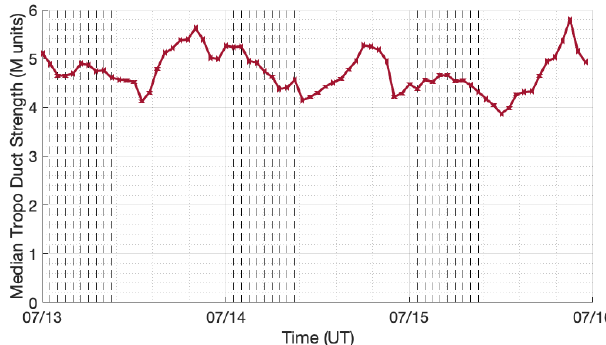
Figure 5. Median nonzero tropospheric duct strength between 25– 50 ◦ N and 85–50 ◦ E between 13–15 July 2021. Nighttime at Bar Harbor, ME, is shown by black dashed